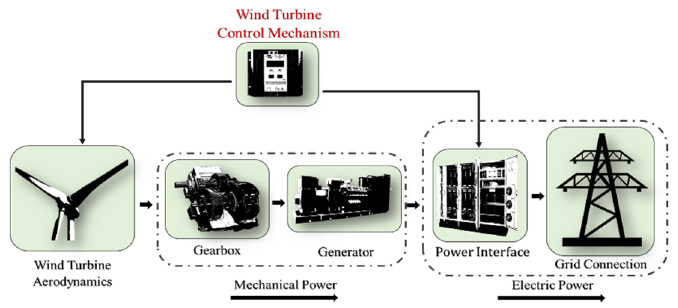
Figure 1. Global scheme of the WT plant.